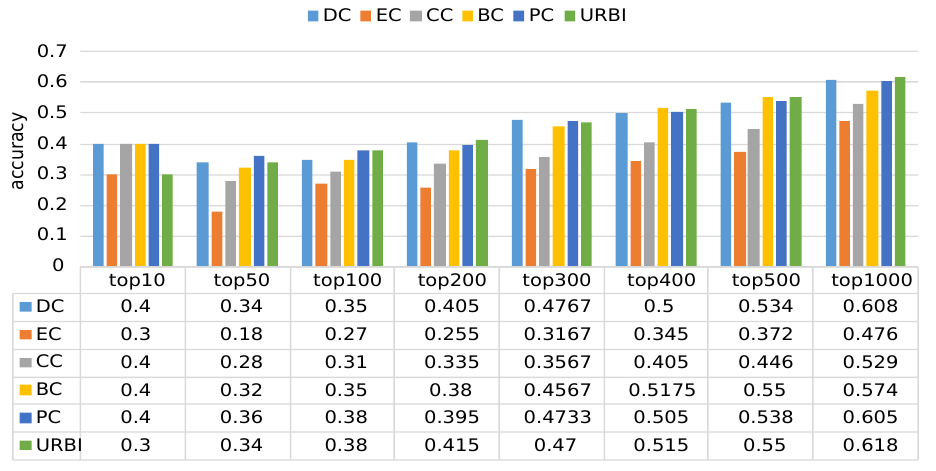
Figure 1. This figure depicts the experimental results of dataset No.1, which contains 6665 book nodes.